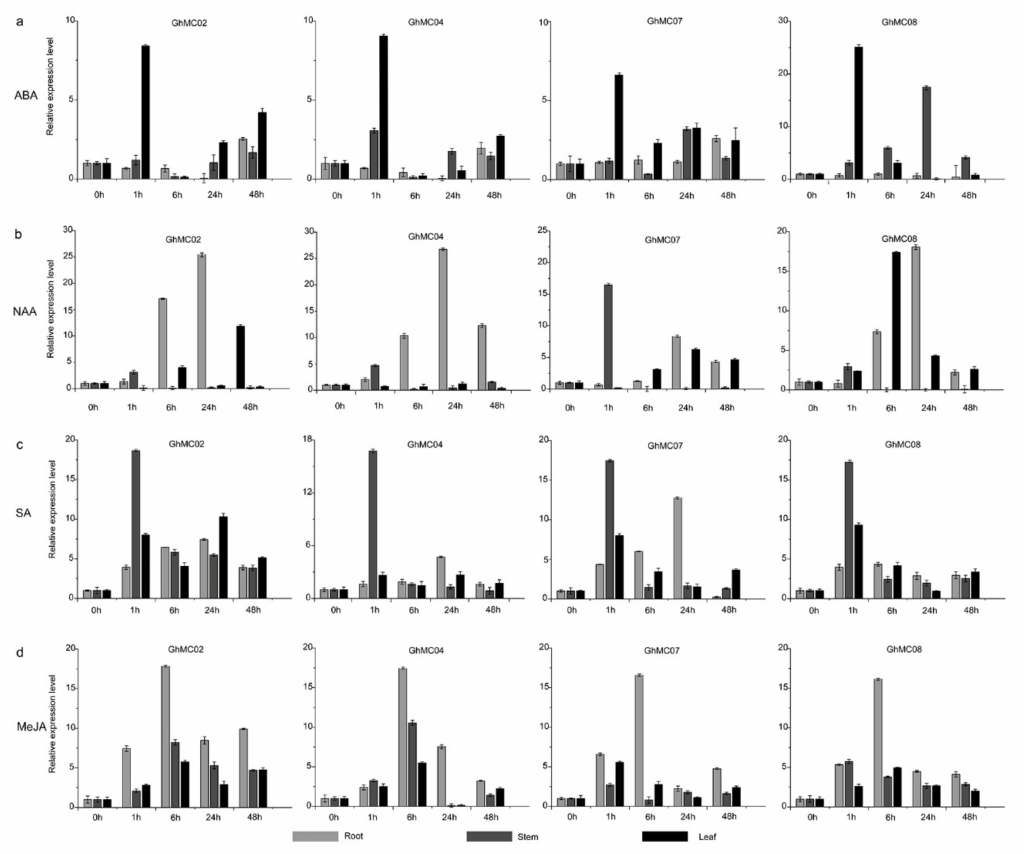
Figure 7. Analysis of GhMC expression levels following phytohormone treatments according to a qRT-PCR assay. ( a ) 100 µ M ABA (abscisic acid) treatment; ( b ) 100 µ M NAA (naphthylacetic acid) treatment; ( c ) 100 µ M SA (salicylic acid) treatment; ( d ) 100 µ M MeJA (methyl jasmonate)